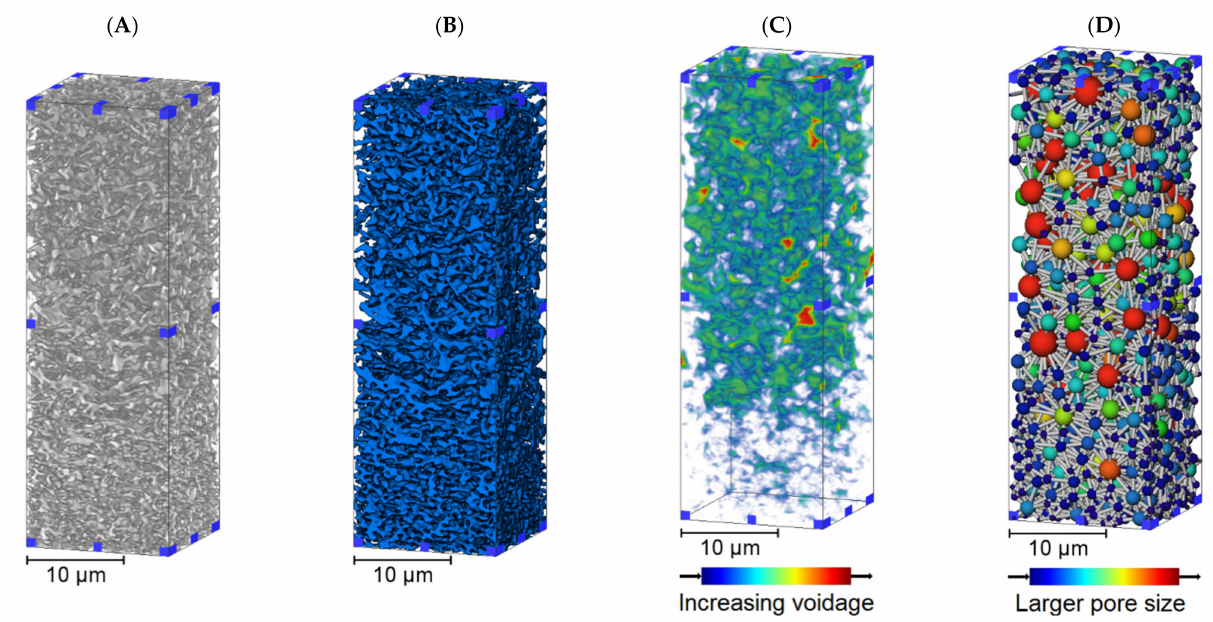
Figure 2. The 3D subvolume renders of the upstream membrane from X-ray CT imaging. Digital representations of the same sample are displayed following reconstruction, processing and phase segmentation. ( A ) A 3D render of an imaged subvolume. ( B ) A 3D render of the subvolume following segmentation with blue representing the material phase. ( C ) Voidage distance map displaying the largest spaces within the subvolume. ( D ) Pore Network Modeling within the